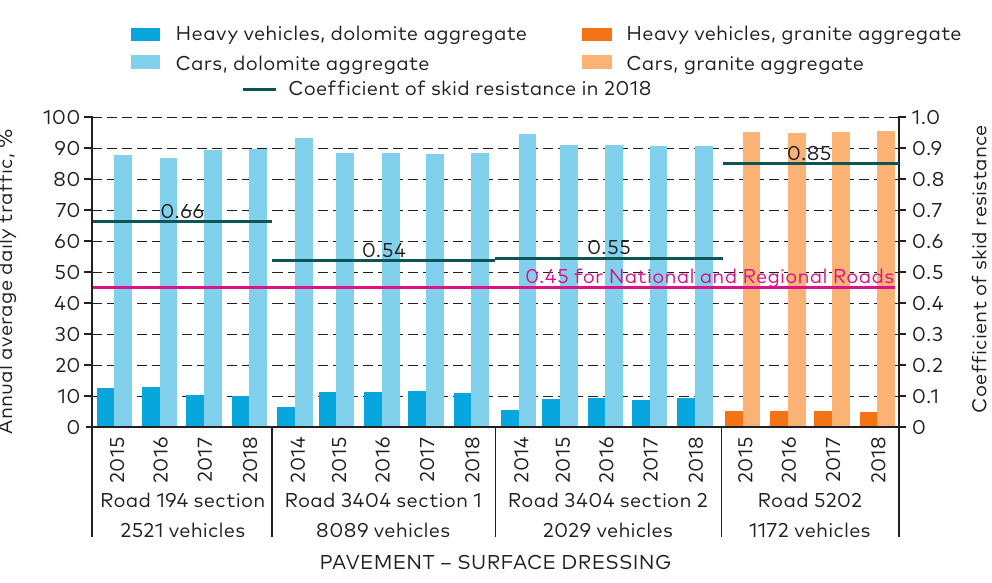
Figure 4. Research results on surface